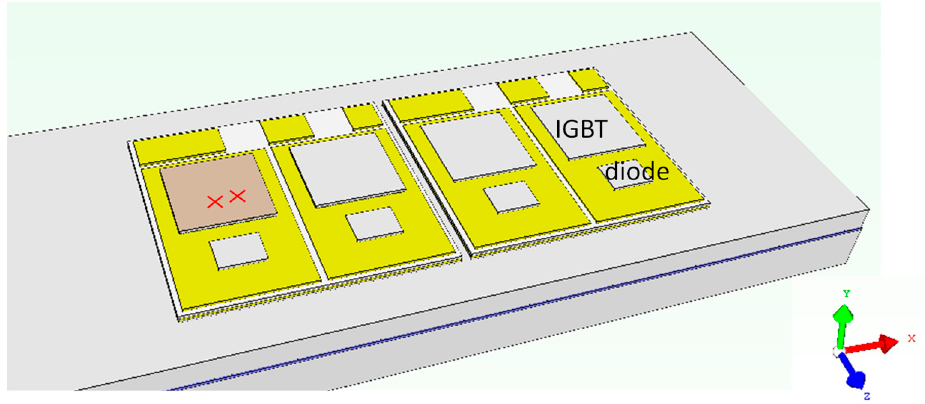
Figure 3. The IGBT module on a cold plate; the left IGBT is powered.